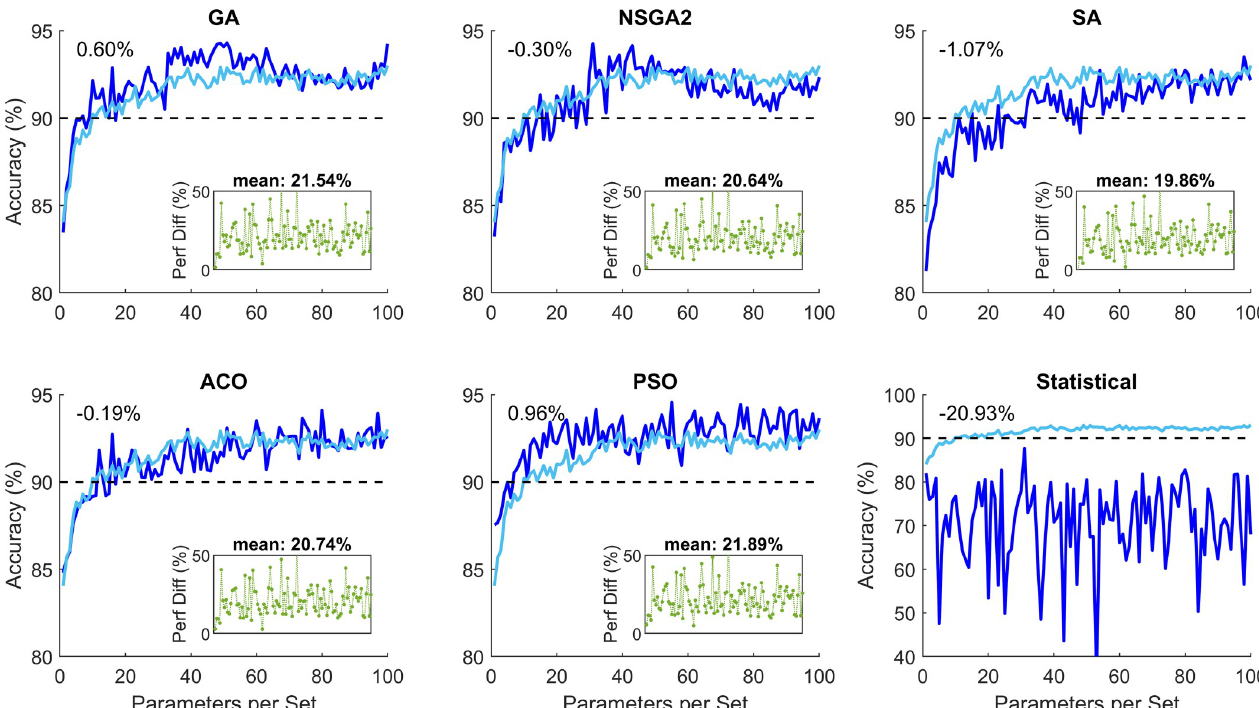
Fig 2. Classification performance of the five evolutionary algorithm (EA) methods and the statistical method for parameter subsets with 1 to 100 elements. The light blue color shows the average of the five EV algorithms. The number on the top left-hand corner represents the difference between the relevant plot and the mean performance of the EA methods. The green plot subplot in each panel represents superiority of the relevant EA as compared to the statistical method for different 100 subsets. The percentage value above the subplot shows the mean superior performance for the 100 subsets compared to the statistical method. These plots show that the EA performed significantly better than the statistical method. GA: Genetic algorithm; NSGA2: Nondominated sorting genetic algorithm II; ACO: Ant colony optimization; SA: Simulated annealing; PSO: Particle swarm optimization.